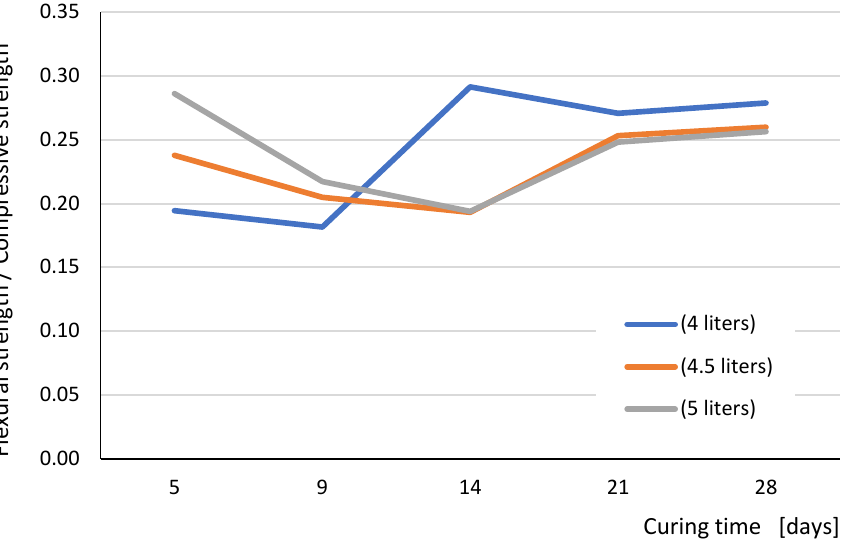
Figure 7. The flexural strength—compressive strength relationships in dependence with the curing time (days) for all tested series.